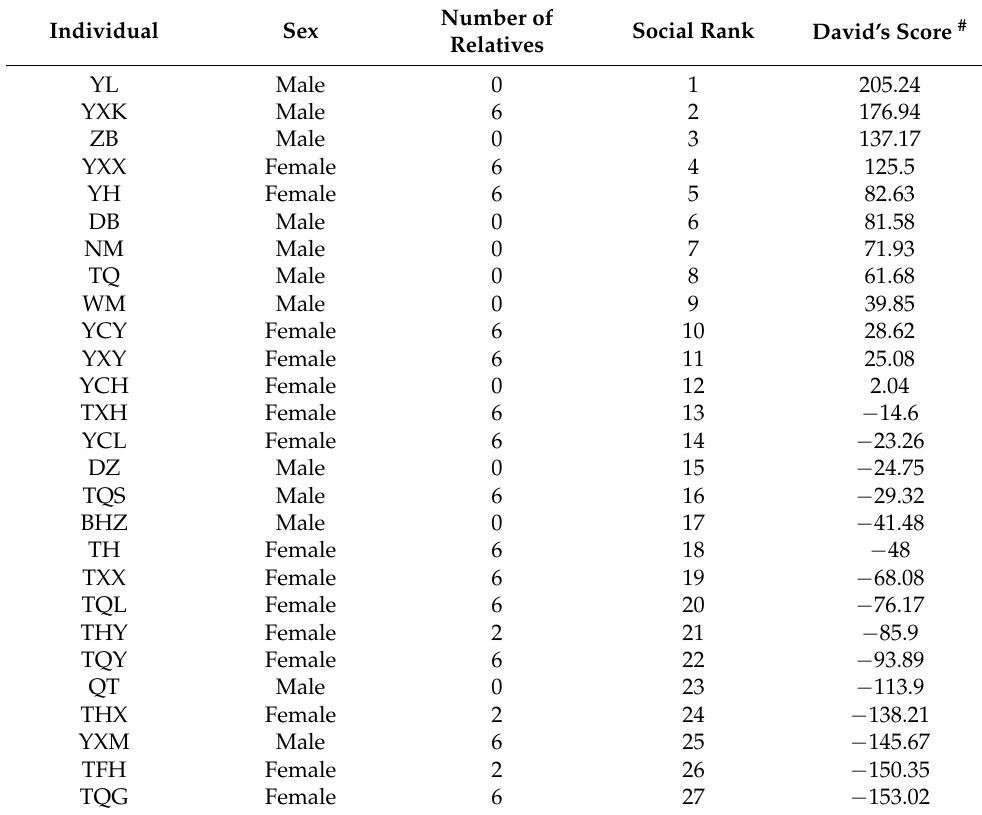
Table 1. Characteristics of focal animals from the YA1 group in observation. Individual Sex